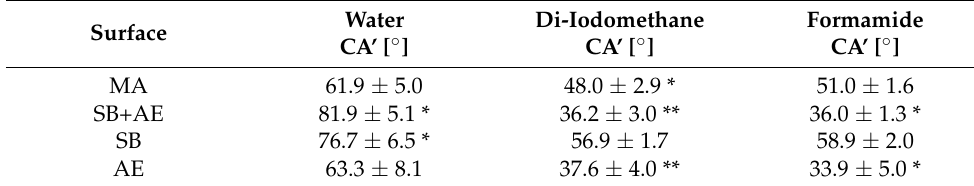
Table 2. Apparent contact angles for the three liquids used on the different c.p. Ti surfaces. Values are mean ± standard error of the mean. Statistical differences vs. smooth surfaces for each column are indicated by single and double asterisk symbols ( p < 0.05).